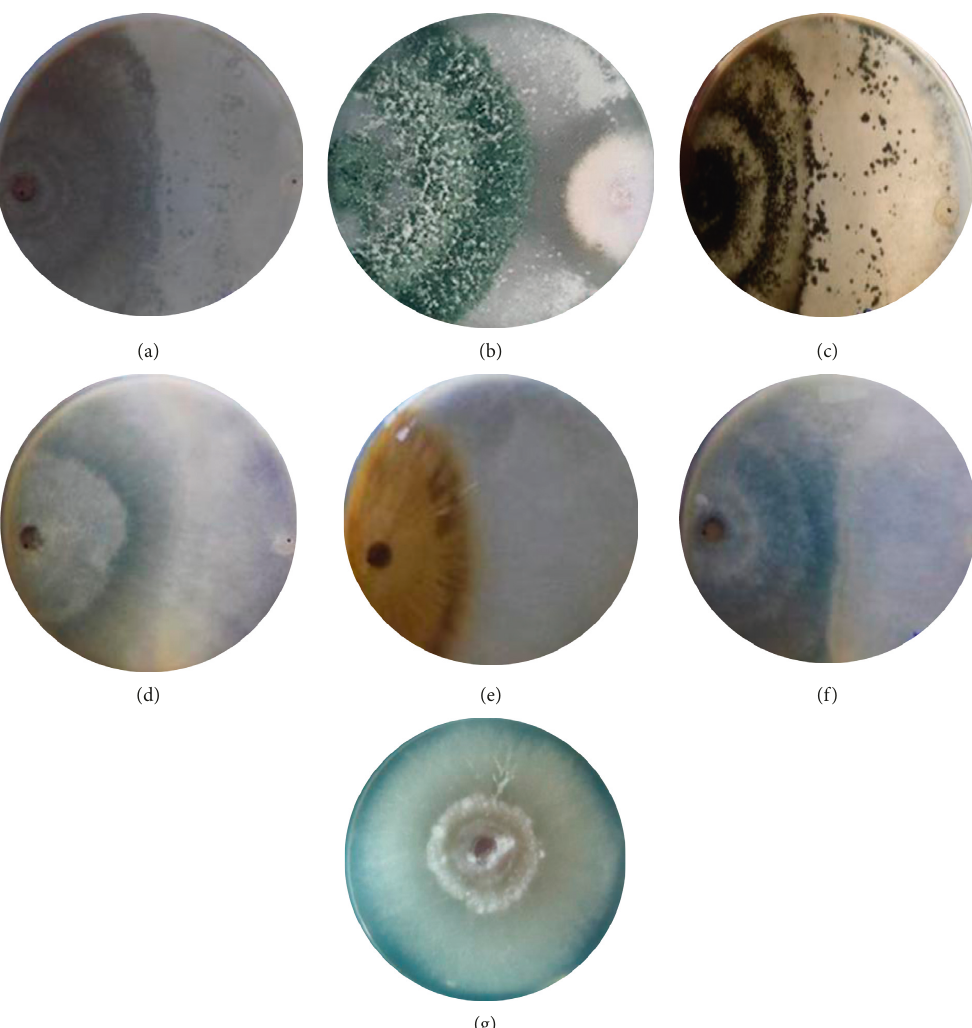
Figure 3: Dual culture assay of Trichoderma strains against a fungal pathogen. (a) T . harzianum + F . oxysporum , (b) T . asperellum + F . oxysporum , (c) T . viride + F . oxysporum , (d) T . hamatum + F . oxysporum , (e) T . virens + F . oxysporum , (f) T . longibrachiatum + F . oxysporum , and (g) control ( F . oxysporum f.sp.capsici